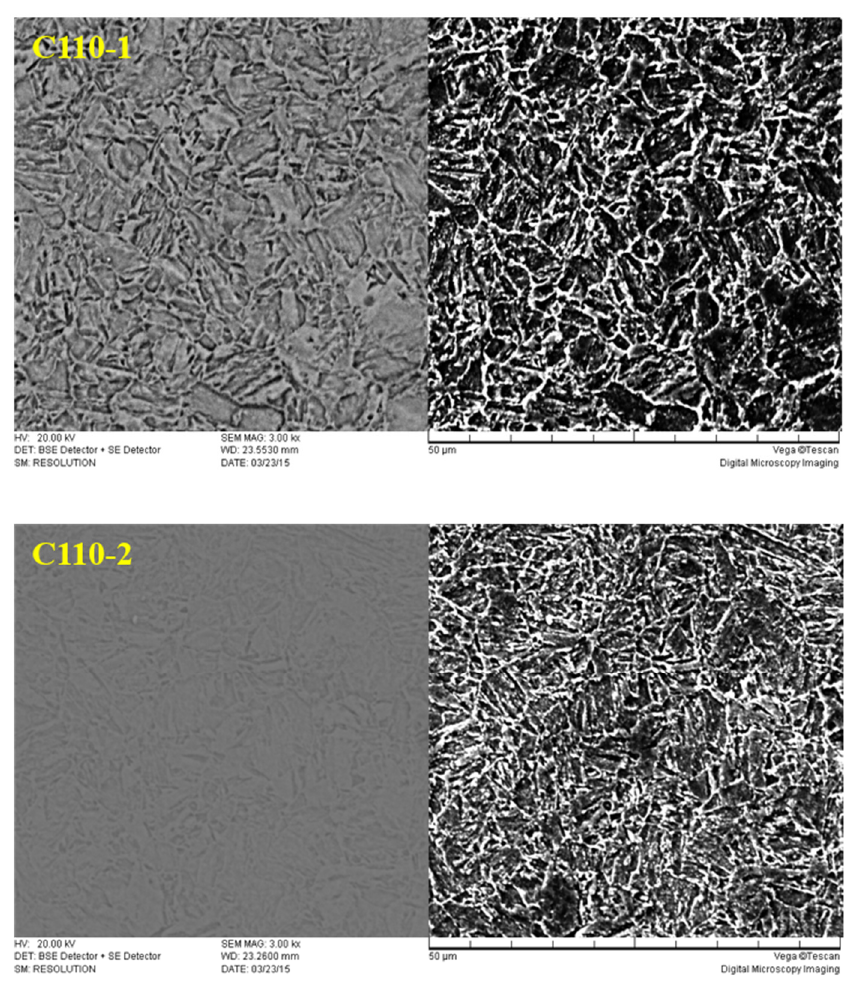
Figure 10. Microstructure of C110-1 and C110-2.